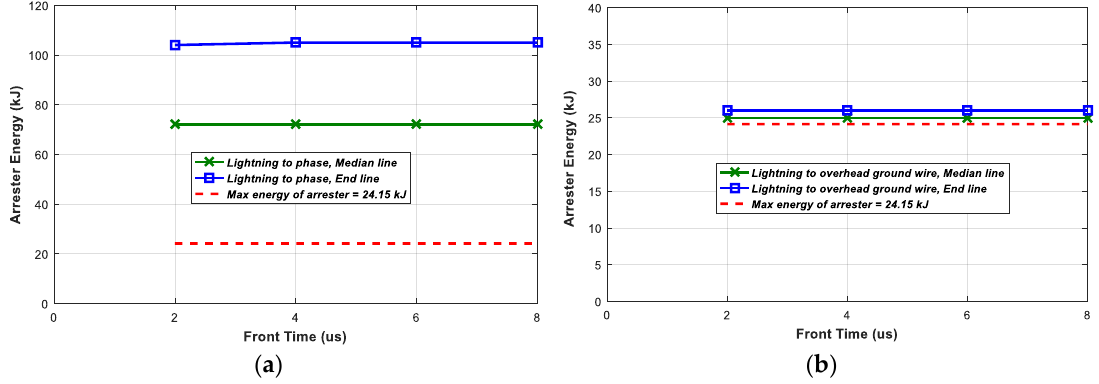
Figure 21. Arrester energy discharge against front time lightning current waveforms (tail time = 77.5